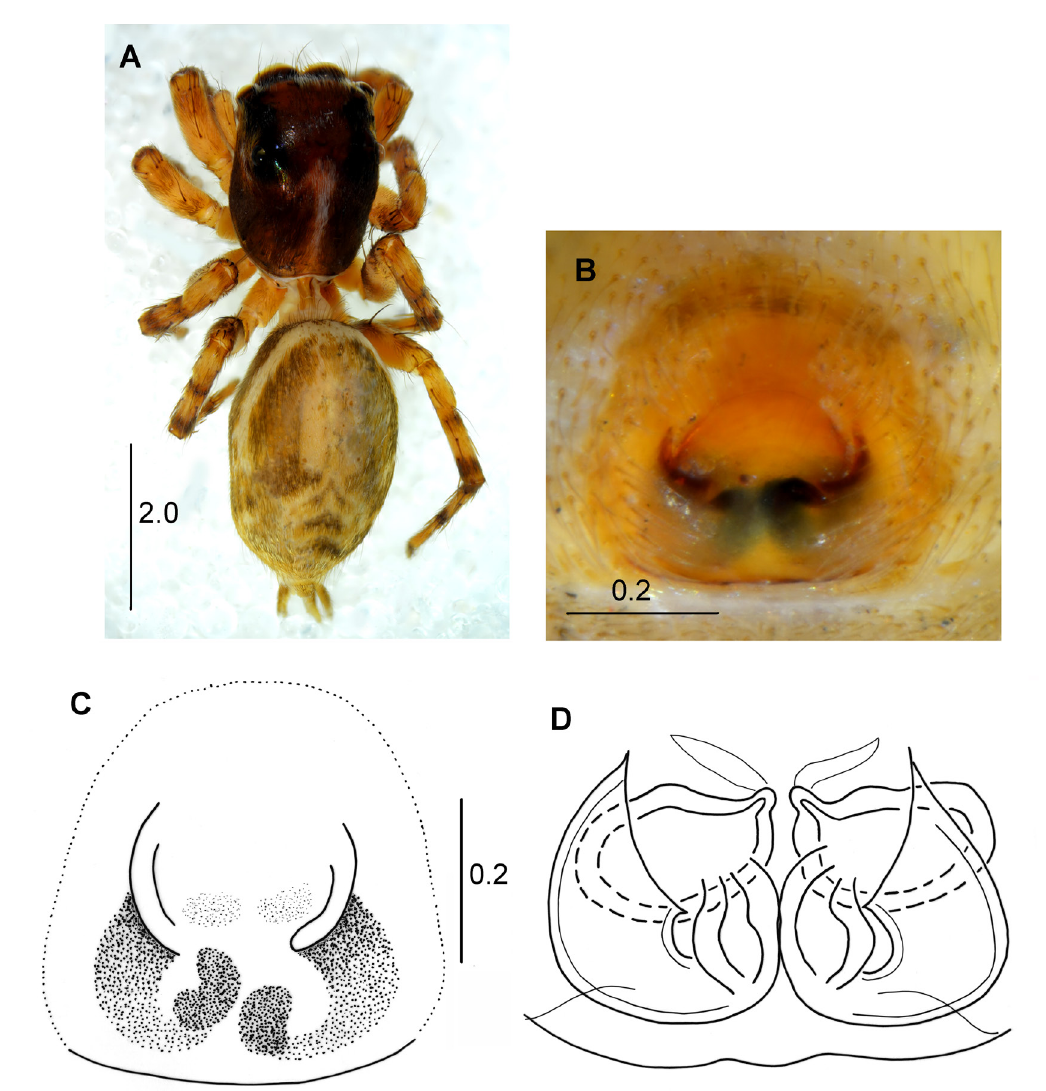
Fig. 75. Tusitala guineensis Berland & Millot, 1941, ♀ (MNHN). A . Habitus, dorsal view. B–C . Epigyne. D . Internal structure of